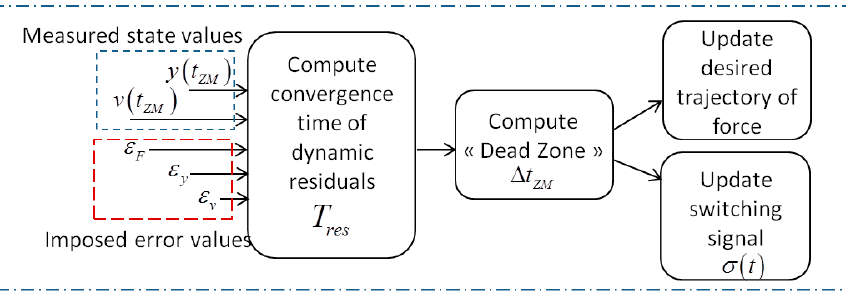
Figure 5. Principle of the proposed solution: case (S 2 ) (S 1 ).